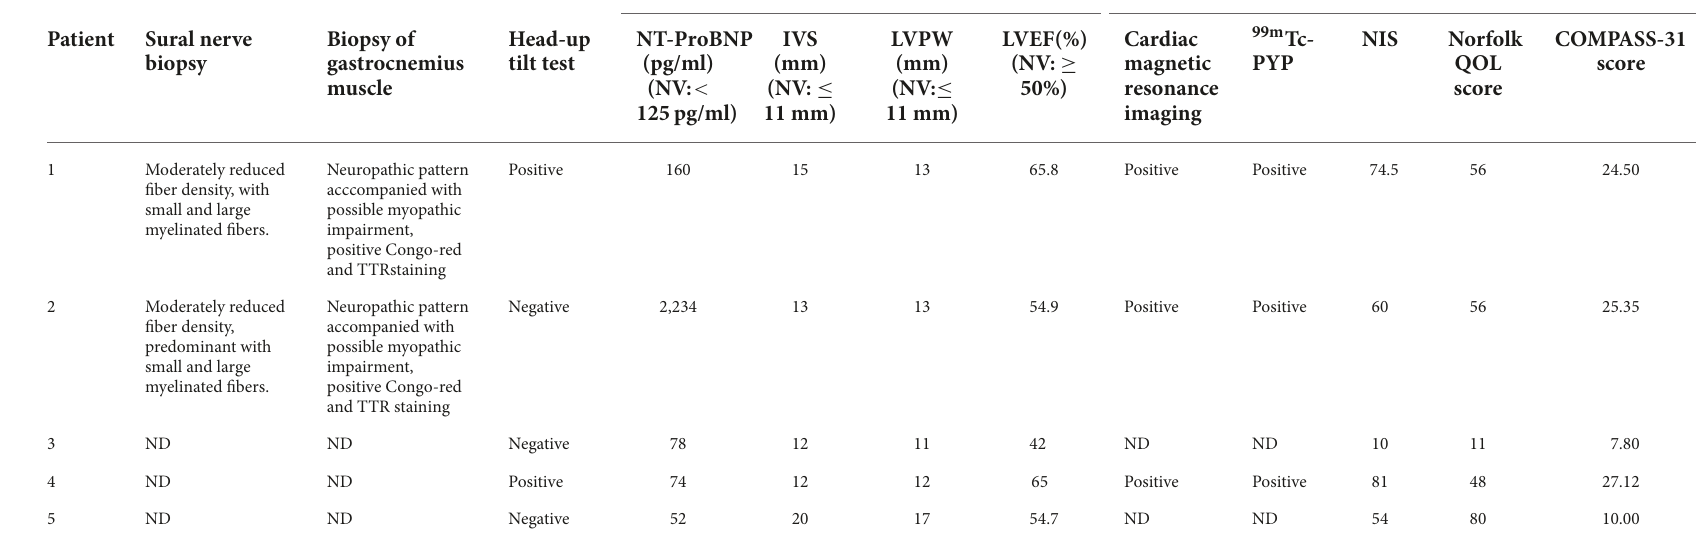
TABLE 2 Examination results of symptomatic ATTR patients with Glu61Lys mutation of symptomatic ATTRv patients with the Glu61Lys variant. Cardiac involvements Clinical evaluation